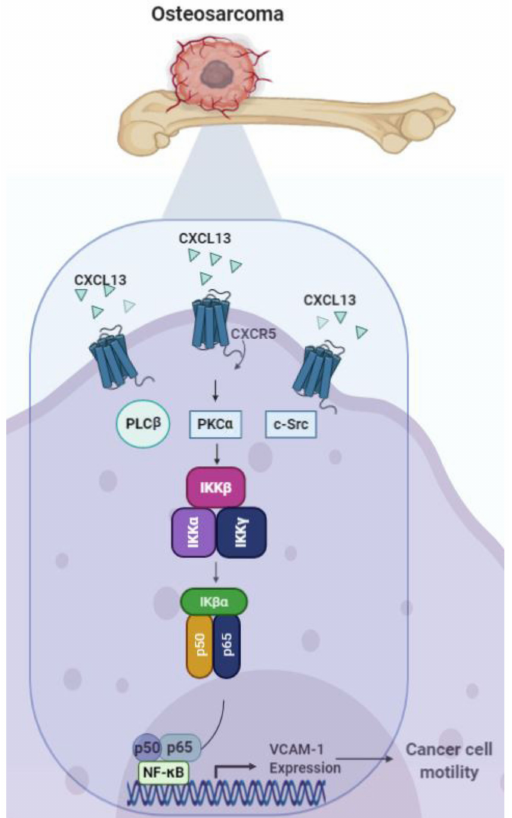
Figure 7. Schema illustrating the e ff ects of the CXCL13 / CXCR5 axis on osteosarcoma cell migration. The CXCL13 / CXCR5 interaction facilitates VCAM-1-dependent migration through the PLC β , PKC α , c-Src, and NF- κ B signaling pathways in human osteosarcoma